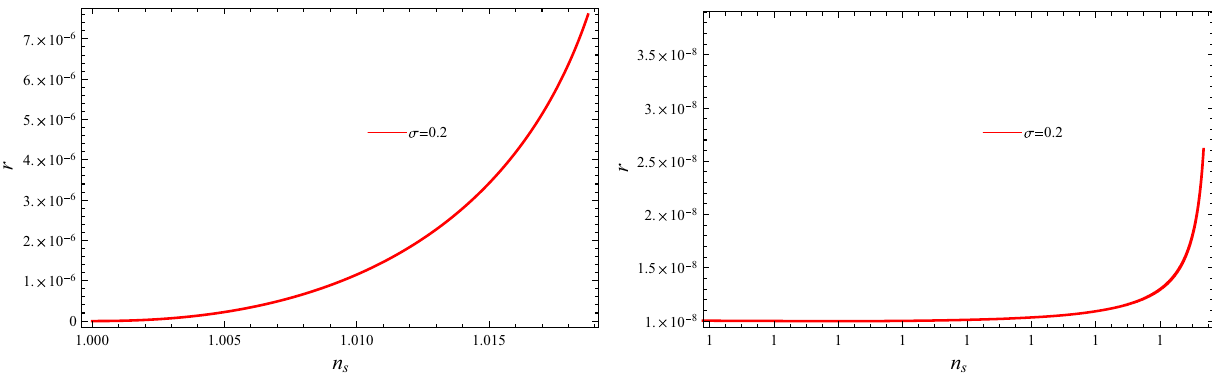
Fig. 12 Plot of r versus n s for MCG model in weak (left panel) and strong (right panel) dissipative regimes for negative potential with n = − 2 Table 4 MCG weak and strong Sr. no dissipative regimes with positive quadratic and quartic potential